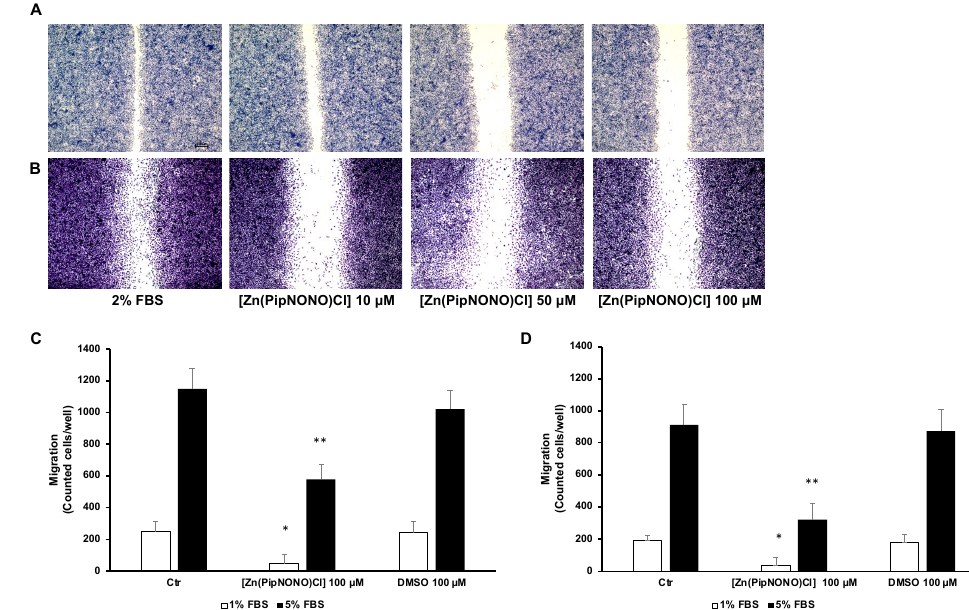
Figure 2. Effect of [Zn(PipNONO)Cl] on the migration and invasiveness of tumor cells. Scratch assay of A549 ( A ) and A375 ( B ) treated with various concentrations (10, 50 and 100 µ M) of [Zn(PipNONO)Cl] for 18 h. Representative images taken with 4× magnification C.D. In the invasion assay, A549 ( C ) and A375 ( D ) were exposed to 100 µM [Zn(PipNONO)Cl] or DMSO (0.1%) and then allowed to migrate toward different serum concentrations (1% and 5%, white and black columns, respectively) put in the lower compartments of the Boyden chamber, the porous filter being coated with gelatin. Number in the graphs are counted cells/well. * p ˂ 0.05 vs. control and DMSO; ** p ˂ 0.01 vs. control and DMSO.